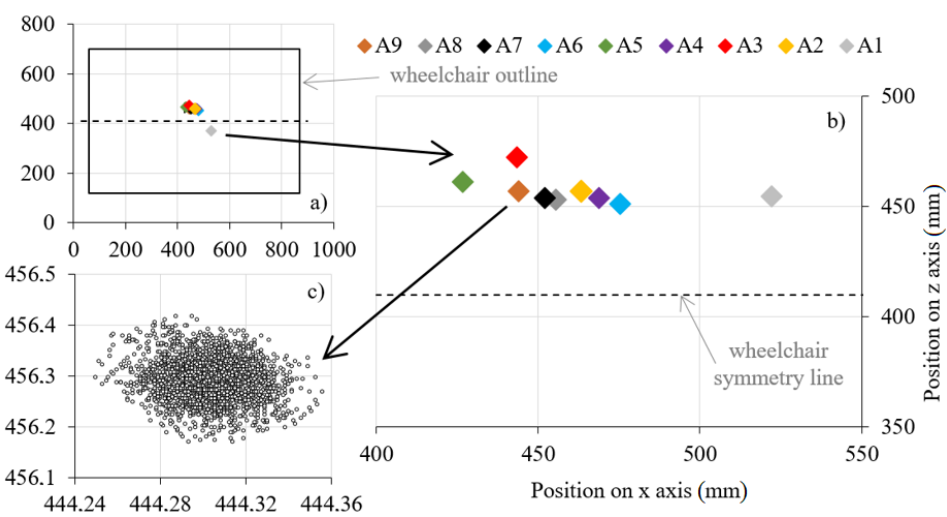
Figure 8. Measurements results of the location of 𝐶𝐺 for individual variants; ( a ) view with the outline of the wheelchair, ( b ) approximate scale view, ( c ) points making up the mean for the selected variant (A1). Table 2. Measurement results for individual variants and calculated values of variable parameters in the simulation; AVG —arithmetic mean, SD —standard